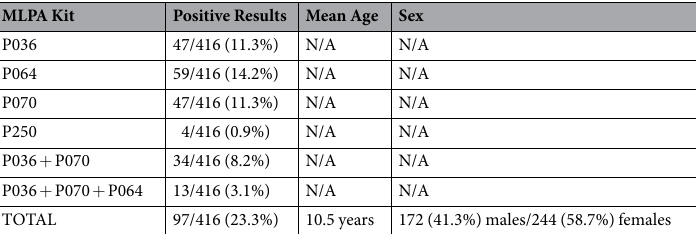
Table 1. Genomic imbalances found by MLPA within the use of different